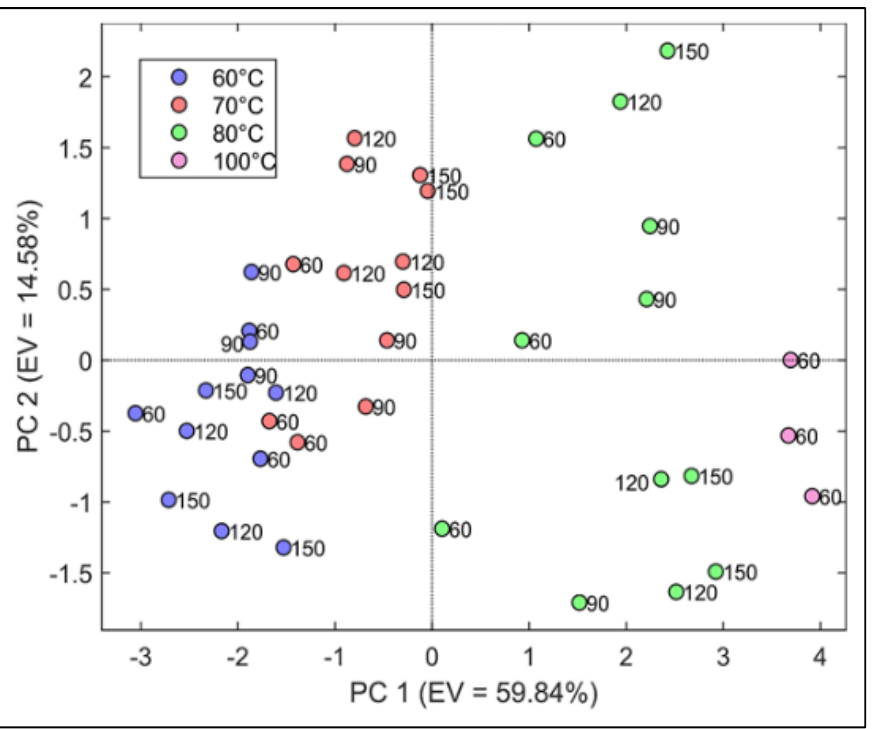
Figure 2. PC1 vs. PC2: Score plot of physicochemical variables studied in sous vide chicken fillet breasts cooked at different combinations of temperature (60, 70, 80, and 100 °C) and time (60, 90, 120, and 150 min). The symbol’s color corresponds to cooking temperature (60, 70, 80, and 100 °C) and the number beside the symbol corresponds to cooking time (60, 90, 120, and 150 min).